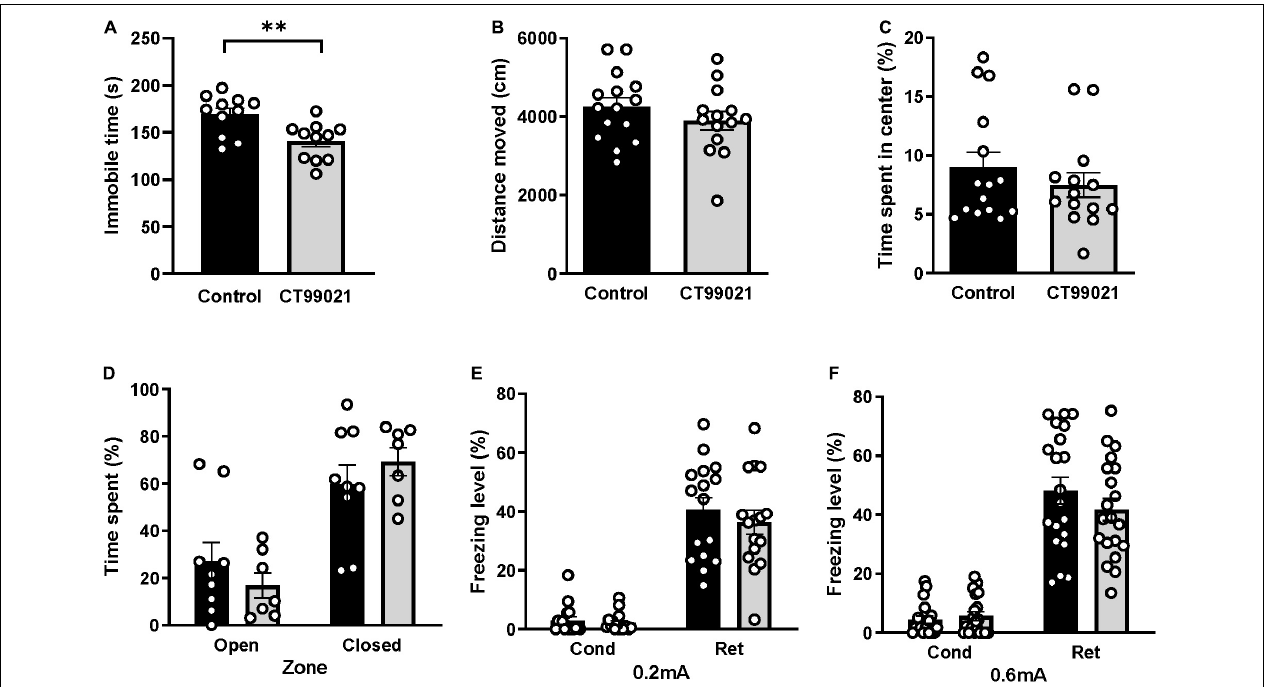
FIGURE 2 | CT99021 does not affect locomotor activity, basal anxiety levels or contextual fear memory. (A) Immobile time (s) measured in the FST 1 h after vehicle ( n = 11) or CT99021 ( n = 11) injection ( ∗∗ p < 0.01, unpaired t -test). (B) Total distance moved (cm) for control ( n = 15) and CT99021-treated ( n = 14) mice in the OFT ( p > 0.05, unpaired t -test). (C) Time spent (%) in the central region of the arena for these same groups of mice in the OFT ( p > 0.05, unpaired t -test). (D) Time spent (%) for control ( n = 9) and CT99021-treated ( n = 7) mice in the open and closed arms of the EPM ( p > 0.05, two-way ANOVA). (E) Freezing level (%) in the contextual fear conditioning test for control ( n = 16) and CT99021 ( n = 16) groups using a 0.2 mA foot shock ( p > 0.05, two-way ANOVA). (F) Freezing level (%) of control ( n = 20) and CT99021 ( n = 20) groups using a 0.6 mA foot shock ( p > 0.05, two-way ANOVA). Cond: conditioning day, Ret: retrieval day. Control: vehicle group (black histograms), CT99021: drug treatment group (gray histograms). Data are presented as mean ±